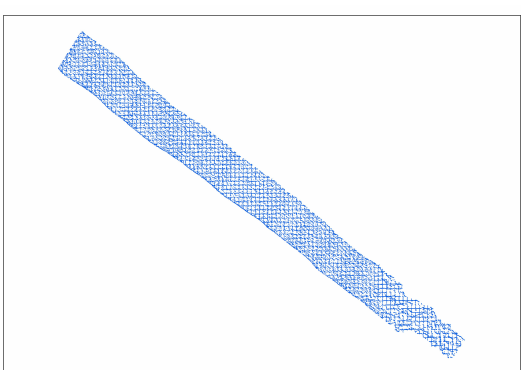
Figure 7. Grid-based thinning method of 5% thinning rate